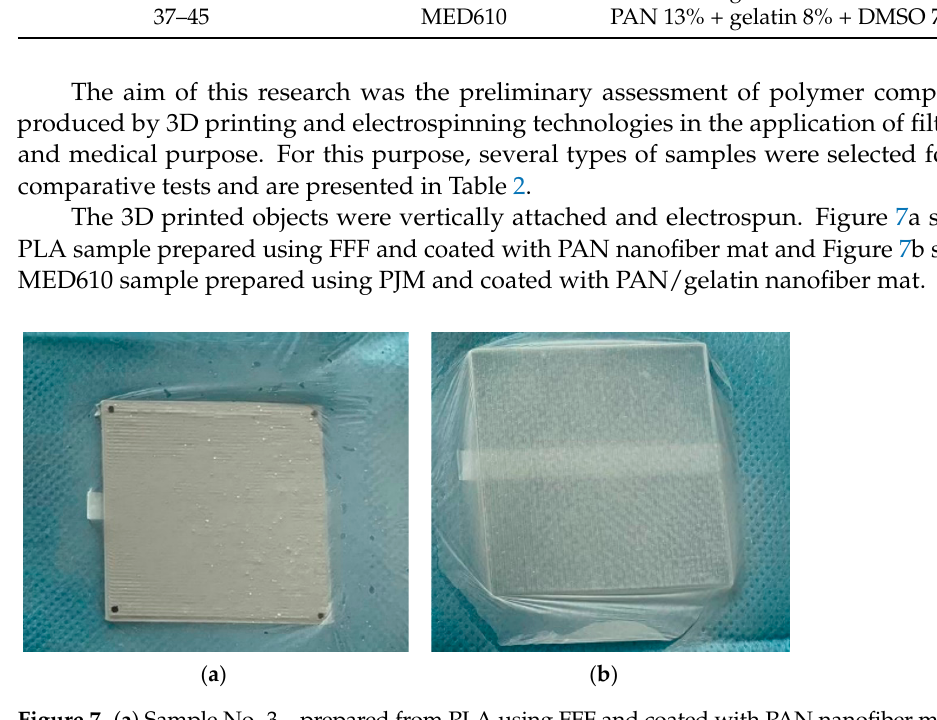
Figure 7. ( a ) Sample No. 3—prepared from PLA using FFF and coated with PAN nanofiber mat and ( b ) sample No. 29—prepared from MED610 using PJM and coated with PAN/gelatin nanofiber mat.